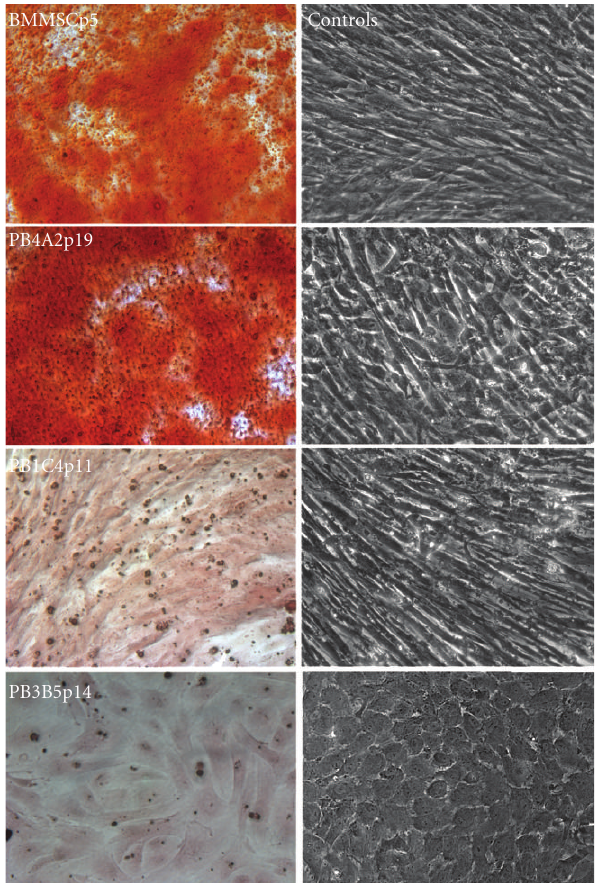
Figure 3: Osteogenic di ff erentiation with companion control populations. Populations of BMMSCp5, PB4A2p19, PB1C4p11, and PB3B5p14 cells were expanded in growth media and then maintained in osteogenic media for 3 to 4 weeks. Robust deposition of calcium, which stains with alizarin red, was generated in BMMSCs and PB4A2 cell populations, but not in PB1C4 or PB3B5 cell populations. The corresponding populations in control media without di ff erentiation supplements are shown in the column on the right. Note the cross- hatched appearance of overly confluent populations of BMMSCp5, PB4A2p19, and PB1C4p11 cells while PB3B5p14 cell populations that apparently ceased proliferation near confluence. Magnification is identical in all